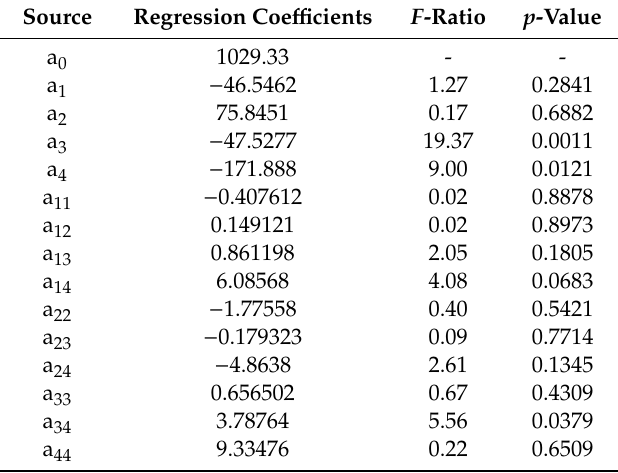
Table 3. Analysis of variance of the regression coe ffi cients of the quadratic model (Equation (2)) for the droplet size of W / O / W